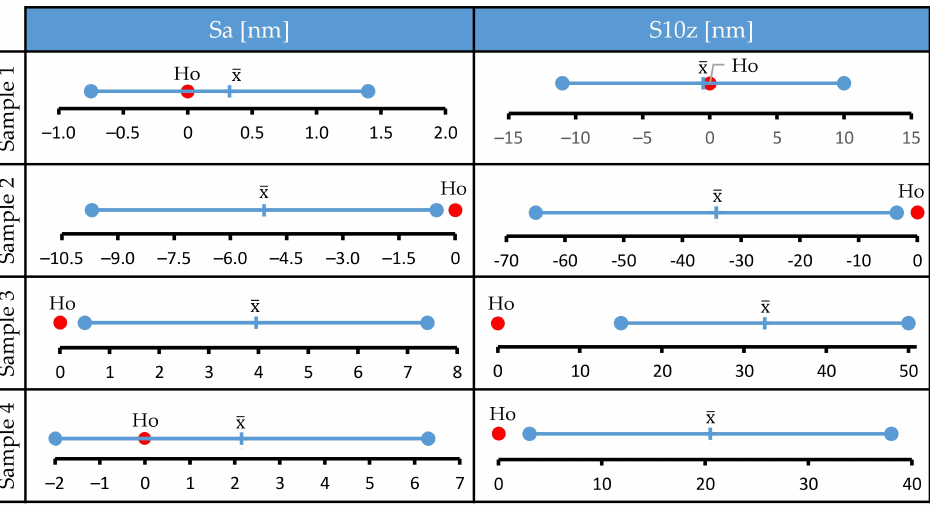
6Figure 6. Results of a paired t test: statistical analysis of the changes in Sa and S10z parameters Figure determined on areas of 10 × 10 µ m before and after the corrosion tests of all